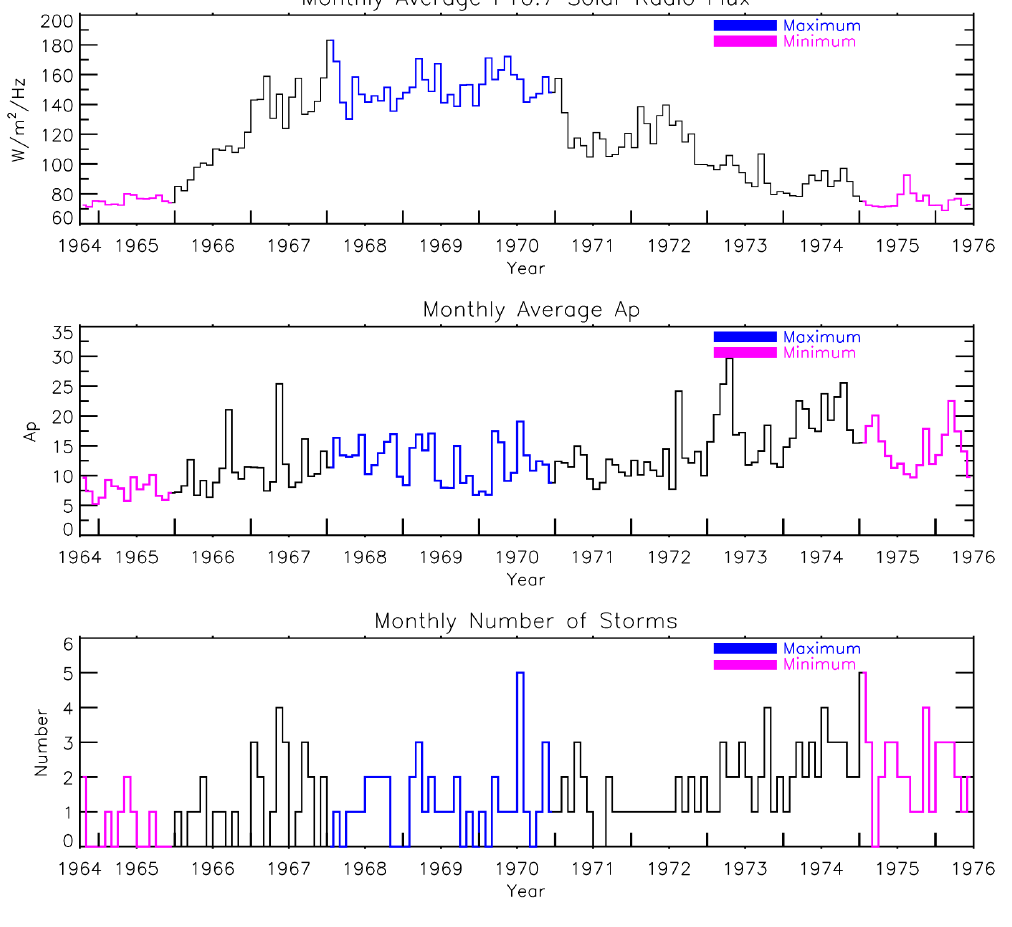
Fig. 1. Characteristics of solar cycle #20 as portrayed by (a) the solar index F10.7 and (b) the geomagnetic index A p . Panel (c) gives the number of storms satisfying the criteria for this study (see text), totaling 206 events. In each panel, coding is used to identify four portions of the solar cycle: Minimum, Rising, Maximum and